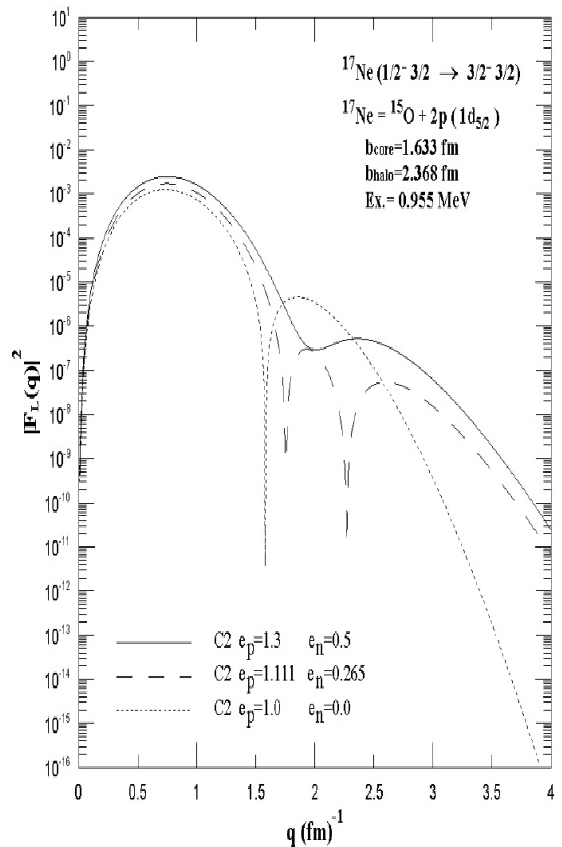
Fig. 8: The calculated inelastic longitudinal C2 form factors of 17 Ne with two protons in 1d orbit and for ( 2323   TJ  )